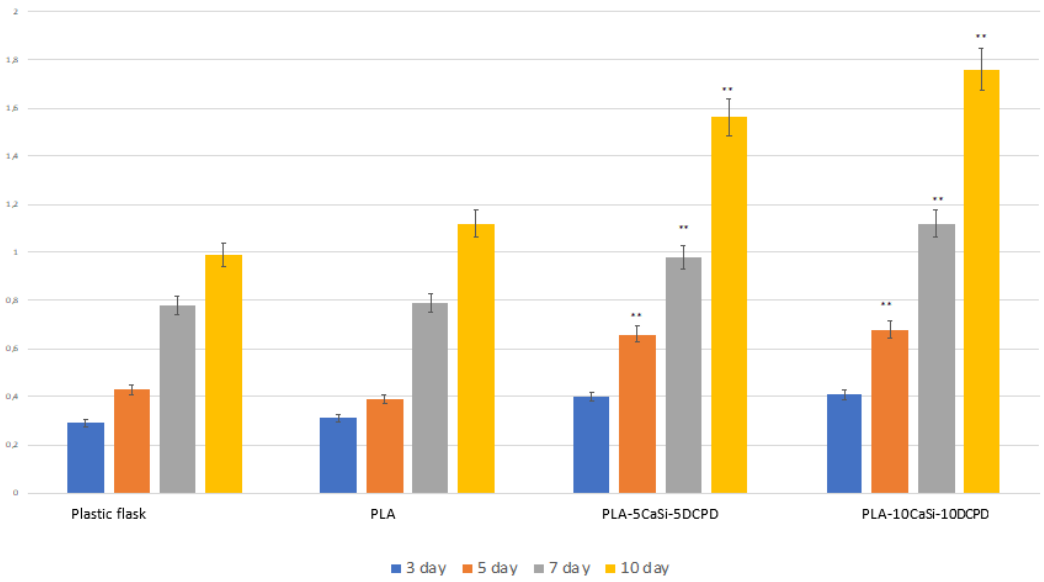
Figure 6. MTT assay of hAD-MSCs cultured for 10 days in plastic flasks without scaffolds, on PLA scaffolds (both used as control) without mineral components, and on PLA-5CaSi-5 DCPD or PLA-10CaSi-10DCPD scaffolds. T-tests were used to determine the significant differences ( p < 0.05). * p < 0.05; ** p < 0.01; *** p < 0.001.